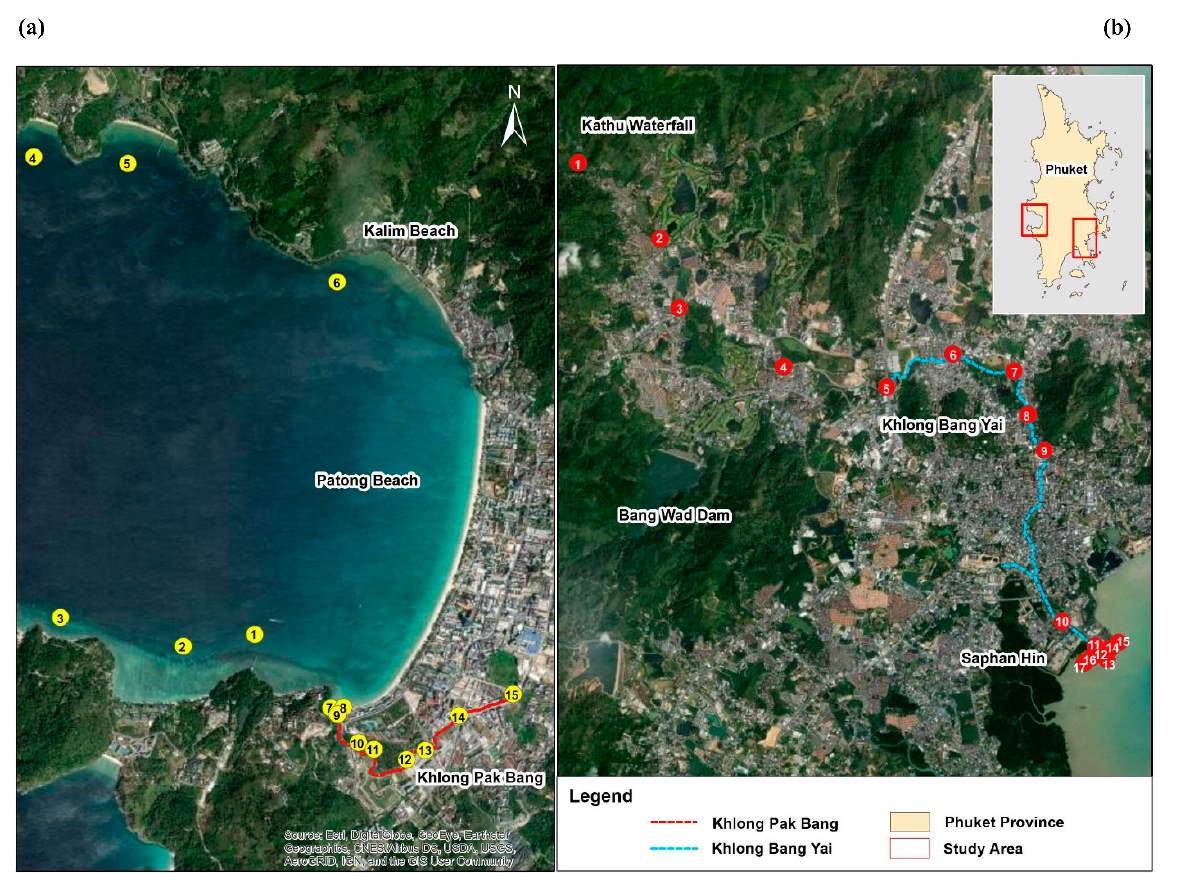
Figure 7. Water sampling points in Thailand: ( a ) Pak Bang canal, Patong; ( b ) Bang Yai canal, Phuket.